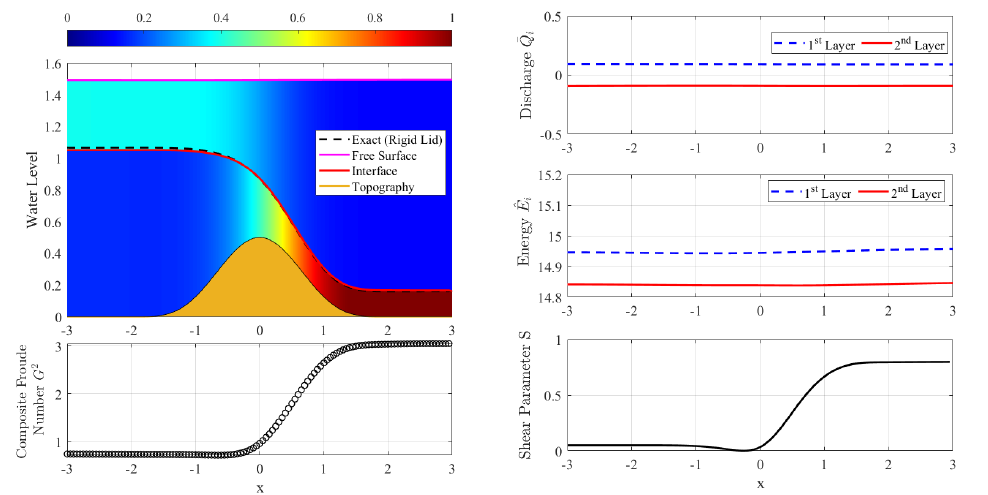
Figure 6. ( Left ) Steady interface in the case of smooth transcritical flow, where both fluid layers flowing in the same direction. The fluid velocity for each layer is represented by the color scale. ( Right ) Plots of discharge and energy for each layer, as well as the shear